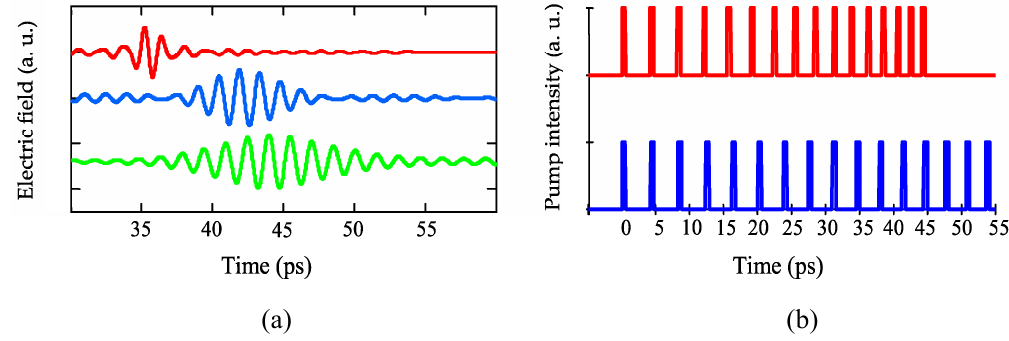
Figure 3. ( a ) Temporal forms of THz pulses generated in APPLN structures having different δ = 1.6 µ m (red curve), δ = 0.8 µ m (blue curve) and δ = 0.5 (green curve), respectively. The temporal forms are offset on the ordinate axis for clarity. In each case the crystal is pumped by the sequence of the laser pulses having delays ∆ τ m with m = 1, 2, 3, . . . 16. ( b ) Format of the pump pulses used for cases δ = 1.6 (red line) and δ = 0.8 (blue line), respectively.